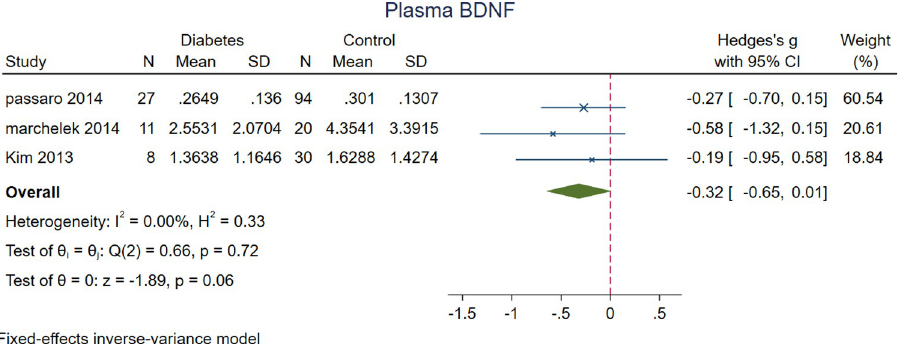
Fig 3. A meta-analysis of plasma BDNF levels in patients with DM vs. controls.